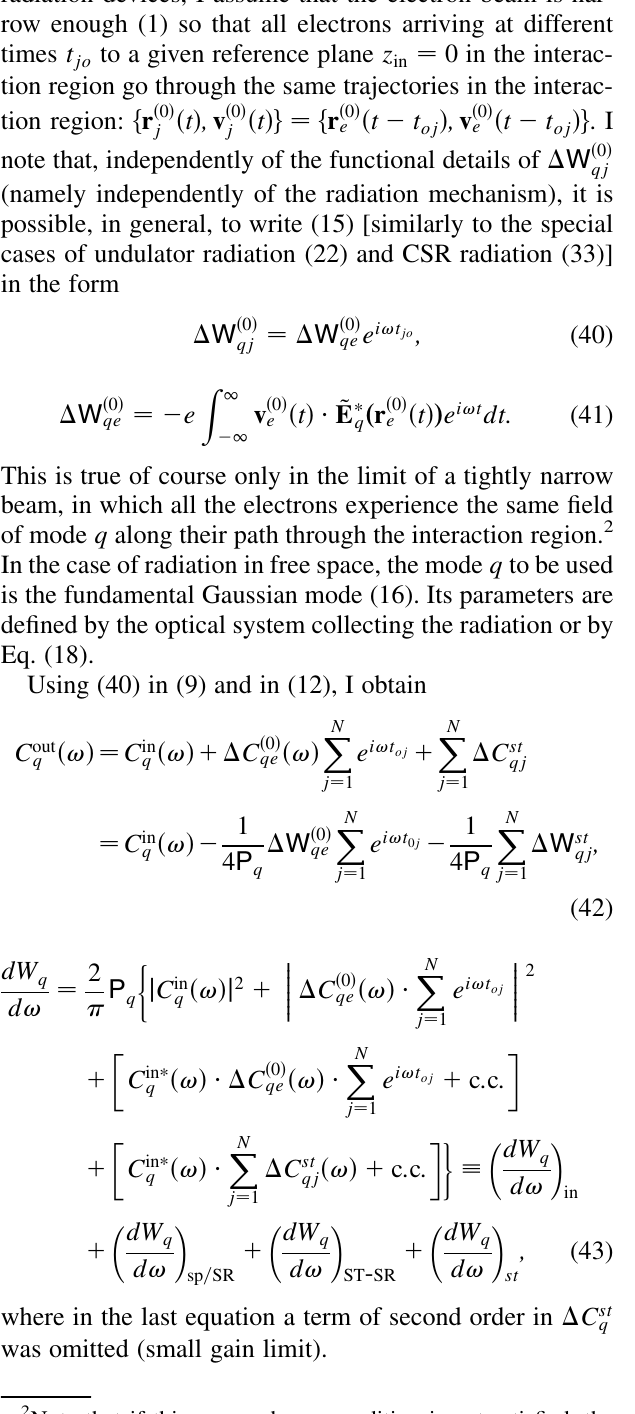
and the superposition of the q : (a) spontaneous emission, qj